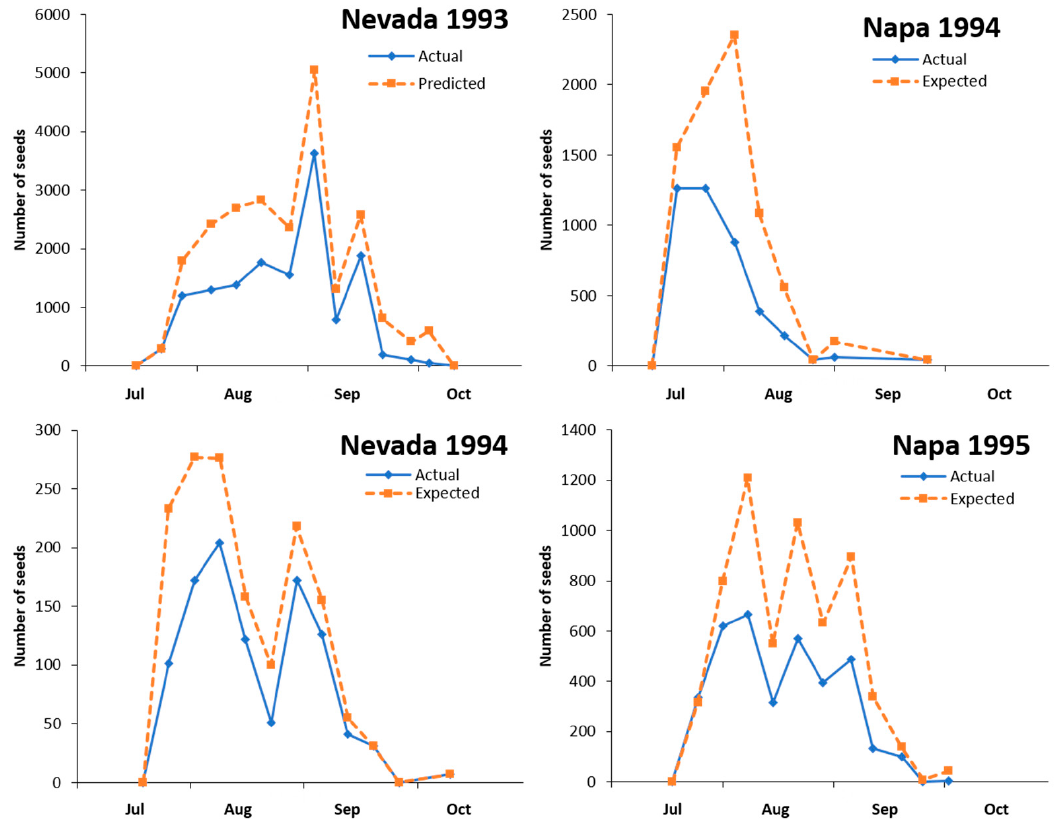
Fig 3 Figure 3. Predicted seed production in the absence of Eustenopus villosus larval feeding and observed seed production for two years at two field